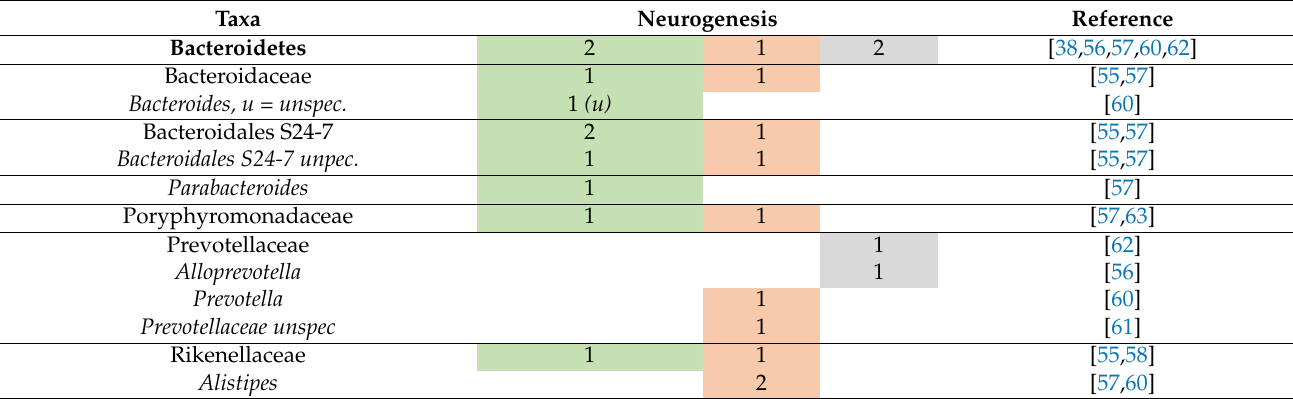
Table 5. Bacteroidetes and